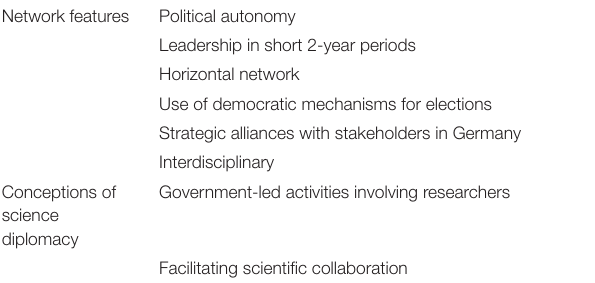
TABLE 3 | INVECA’s